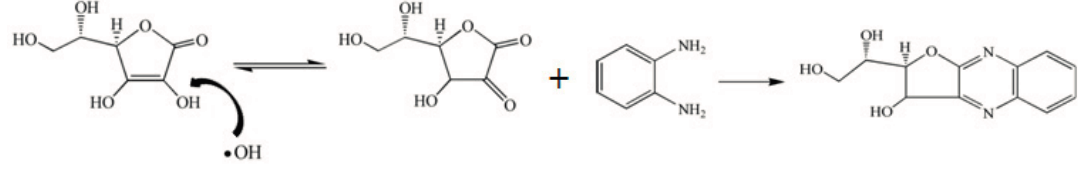
Figure 3. The possible mechanism of condensation reactions of VIT-C with o -phenylenediamine by PEF